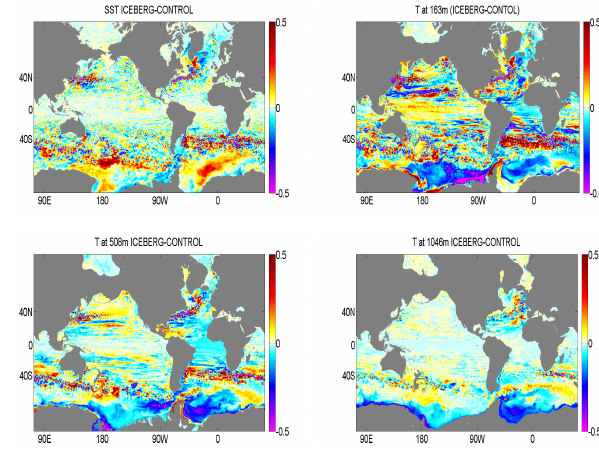
Figure 6. Changes in the global fields of salinity at selected depth levels (surface, 163, 508, 1046m), averaged over years 26–30.